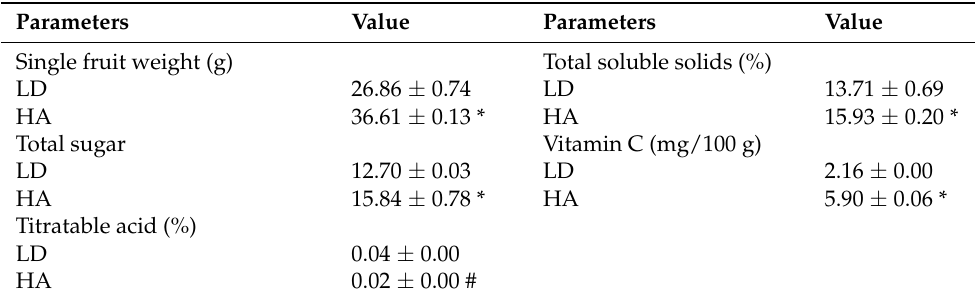
Table 2. Effects of humic acid on fruit quality of decline diseased